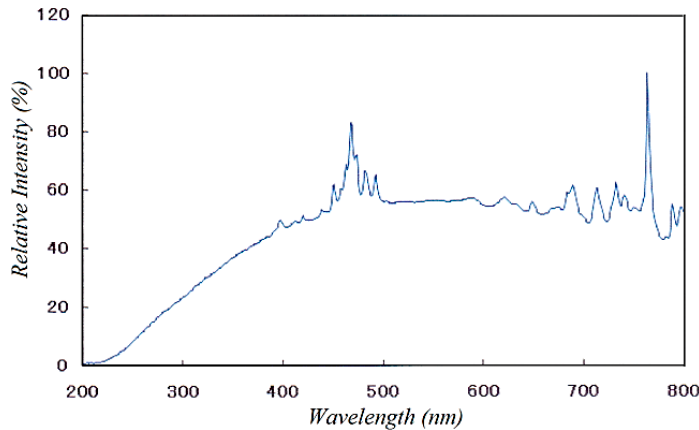
Figure 2. Heating curve for the specimen.